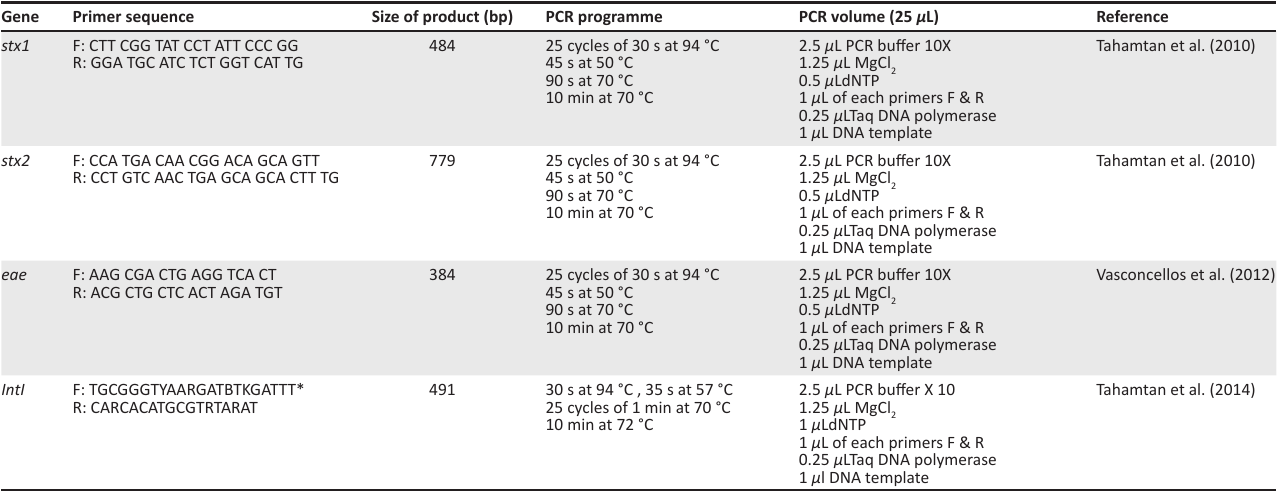
TABLE 1: Primers and polymerase chain reaction conditions used in this study. Gene Primer sequence